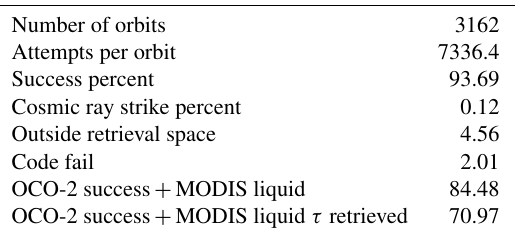
Table 4. Statistics of a test sample of OCO2CLD-LIDAR output.